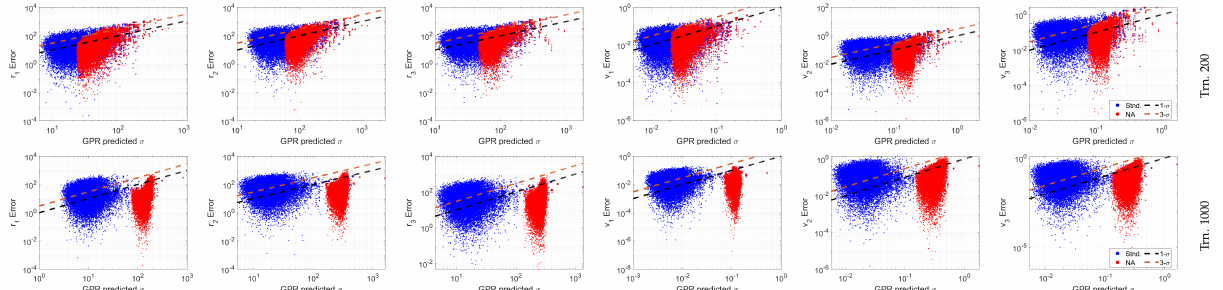
Figure 12. Predicted standard deviation versus the error between the predicted mean and the true Cartesian state given uncertain angular measurements.